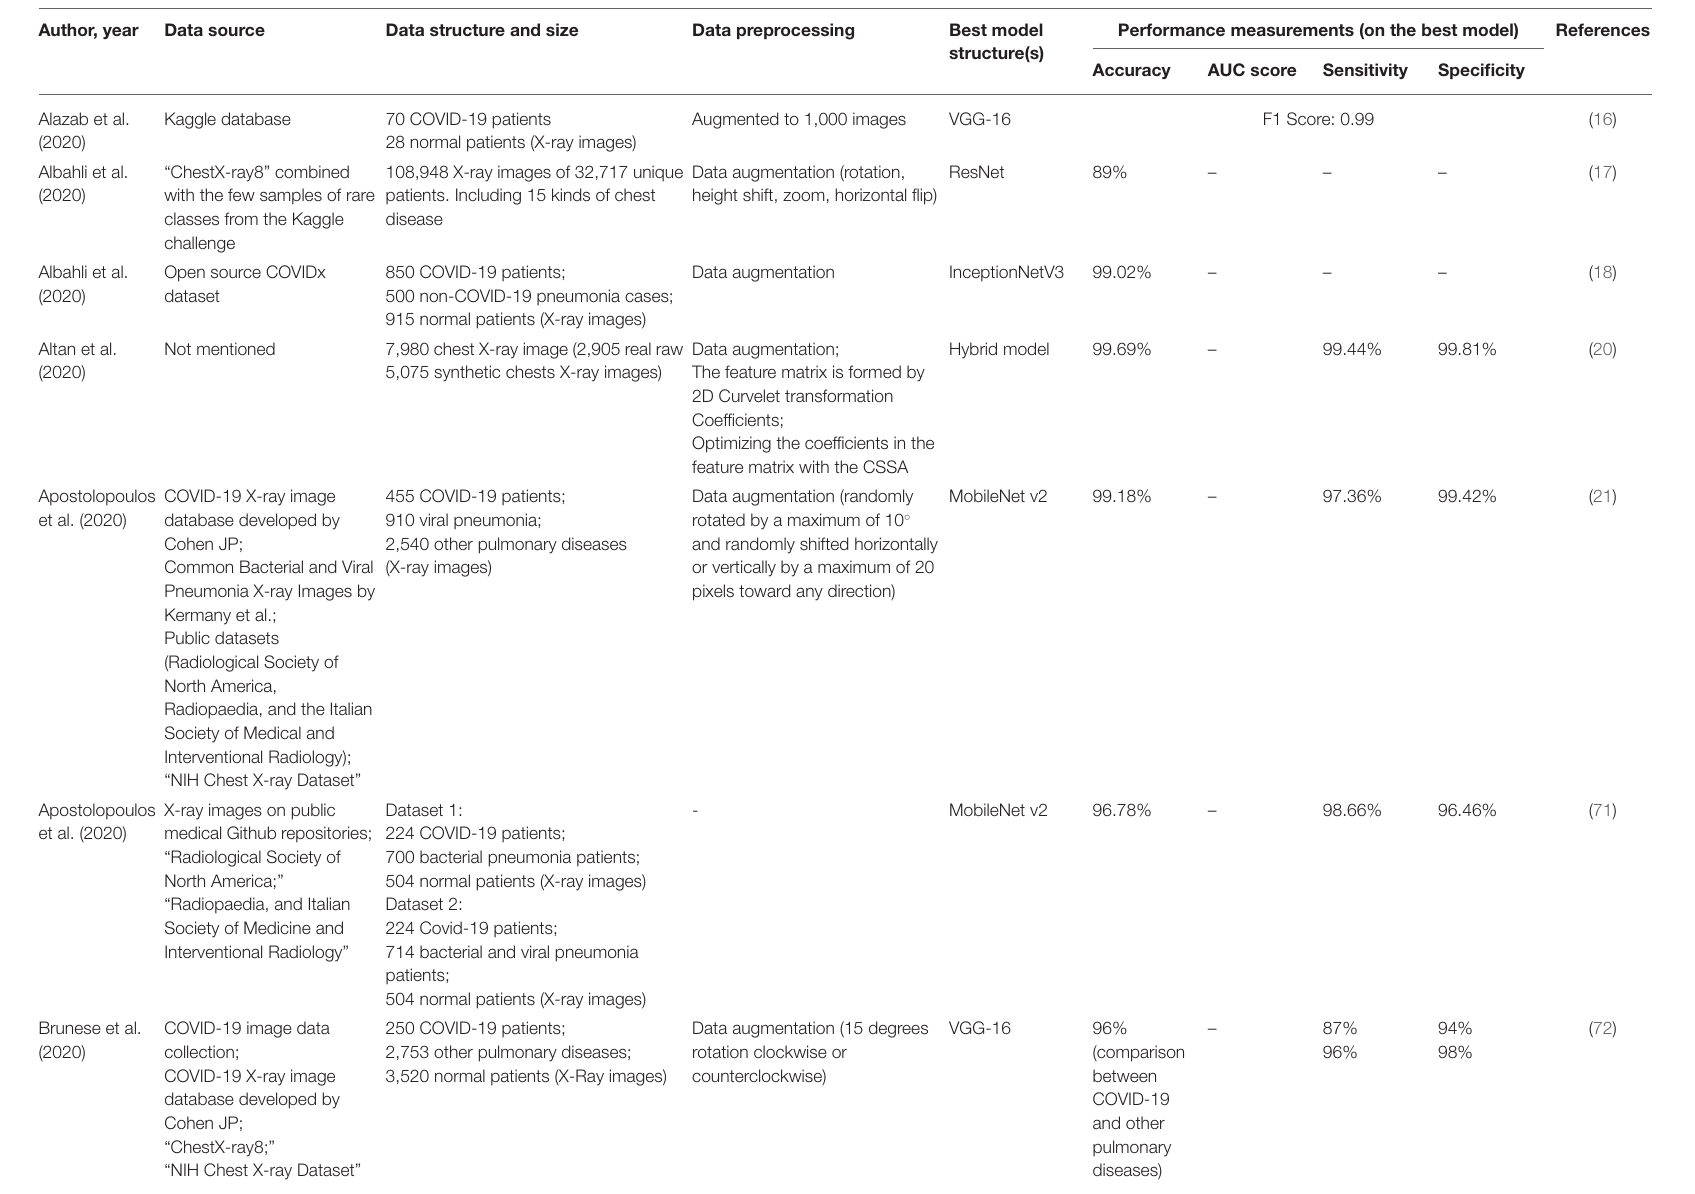
TABLE 2 | Characteristics of papers that used X-ray